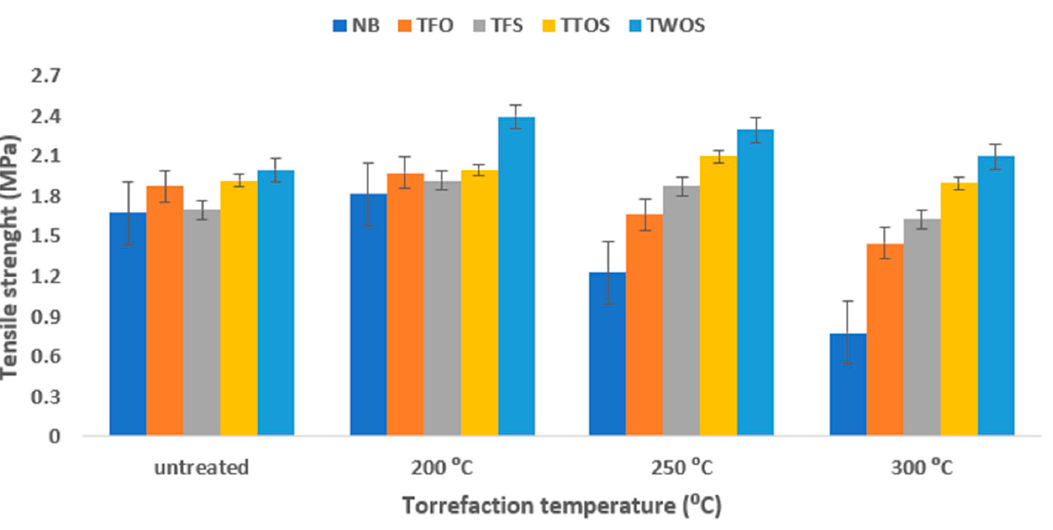
Figure 8. Tensile strength of pellets from WSS untreated and torrefied with or without binders. NB: Without binder; TFO: 75% torrefied WSS with 25% TL; TFS: 75% torrefied WSS with 25% sawdust; TTOS: 33.3% torrefied WSS with 33.3% sawdust and TL; TWOS: 75% torrefied WSS with 12.5% sawdust and TL each.